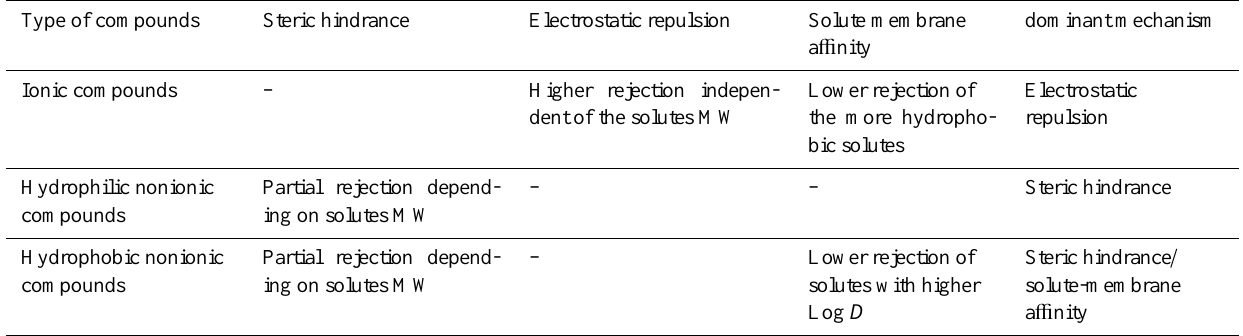
Table 4. Summary of rejection mechanisms observed for the trace organic compounds (MW < 270gmol − 1 ) by virgin